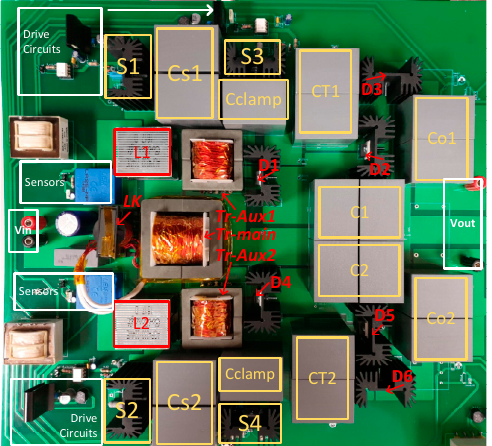
Figure 10. Implementation of the proposed converter.